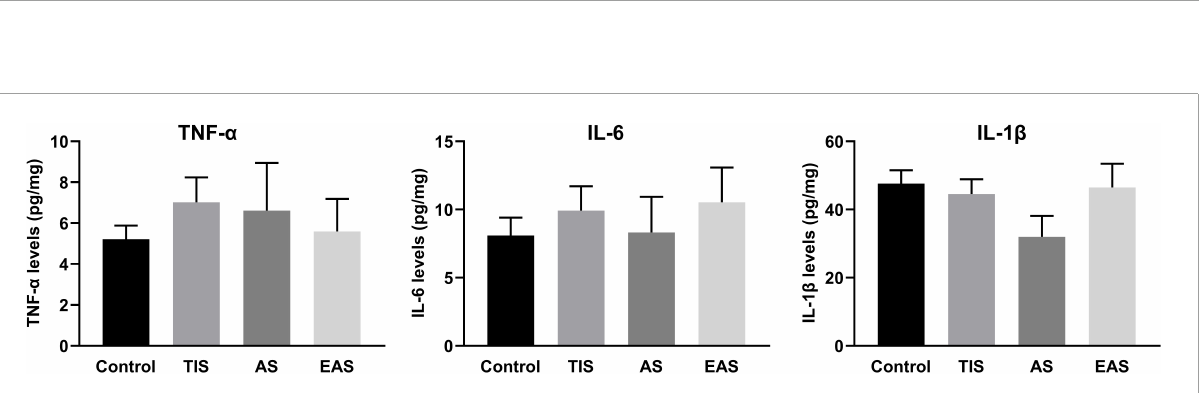
FIGURE6 Hippocampal inflammatory cytokine levels after the end of all behavioral tests. There were no significant differences between groups in TNF- α , IL-6, and IL-1 β levels in the hippocampus. Data represent mean ± SEM ( n = 9–12 per